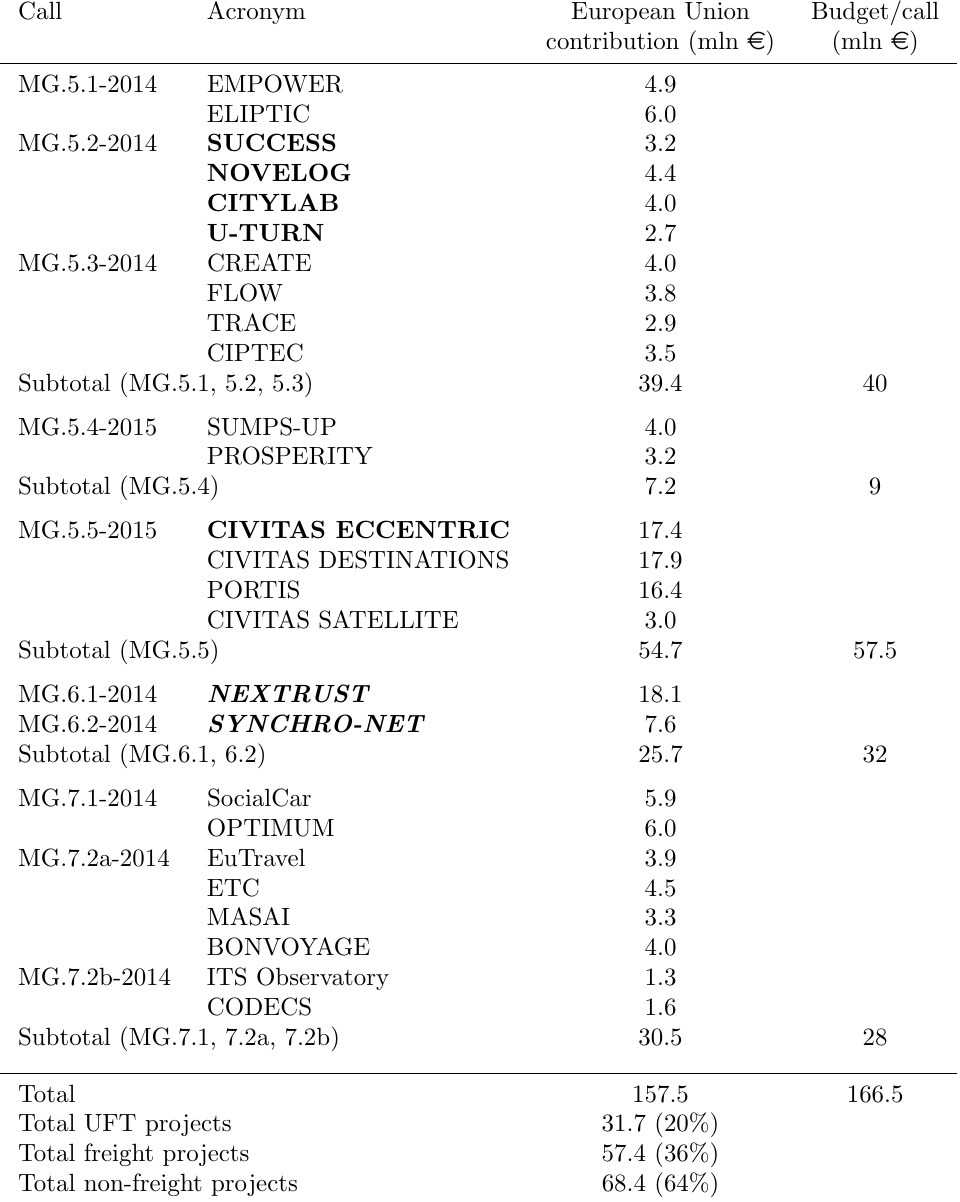
Table 5: Comparison between the resources potentially available and the ones actually allocated (Work Programme